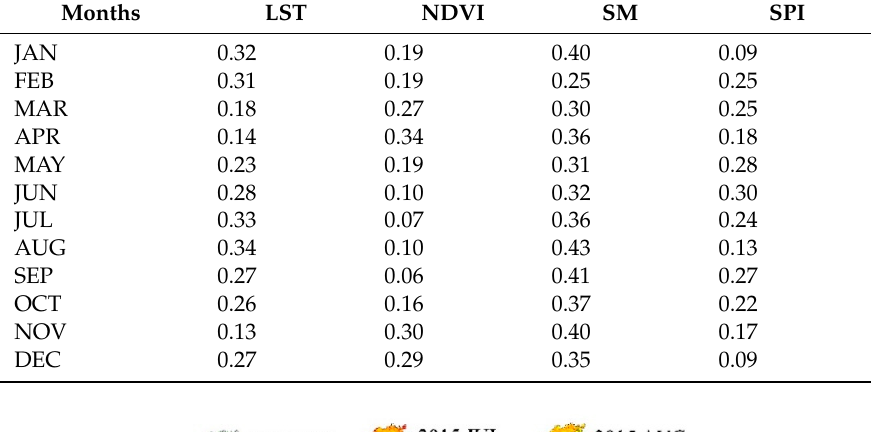
Table 5. PCA-based spatially averaged monthly mean weight values for input parameters.